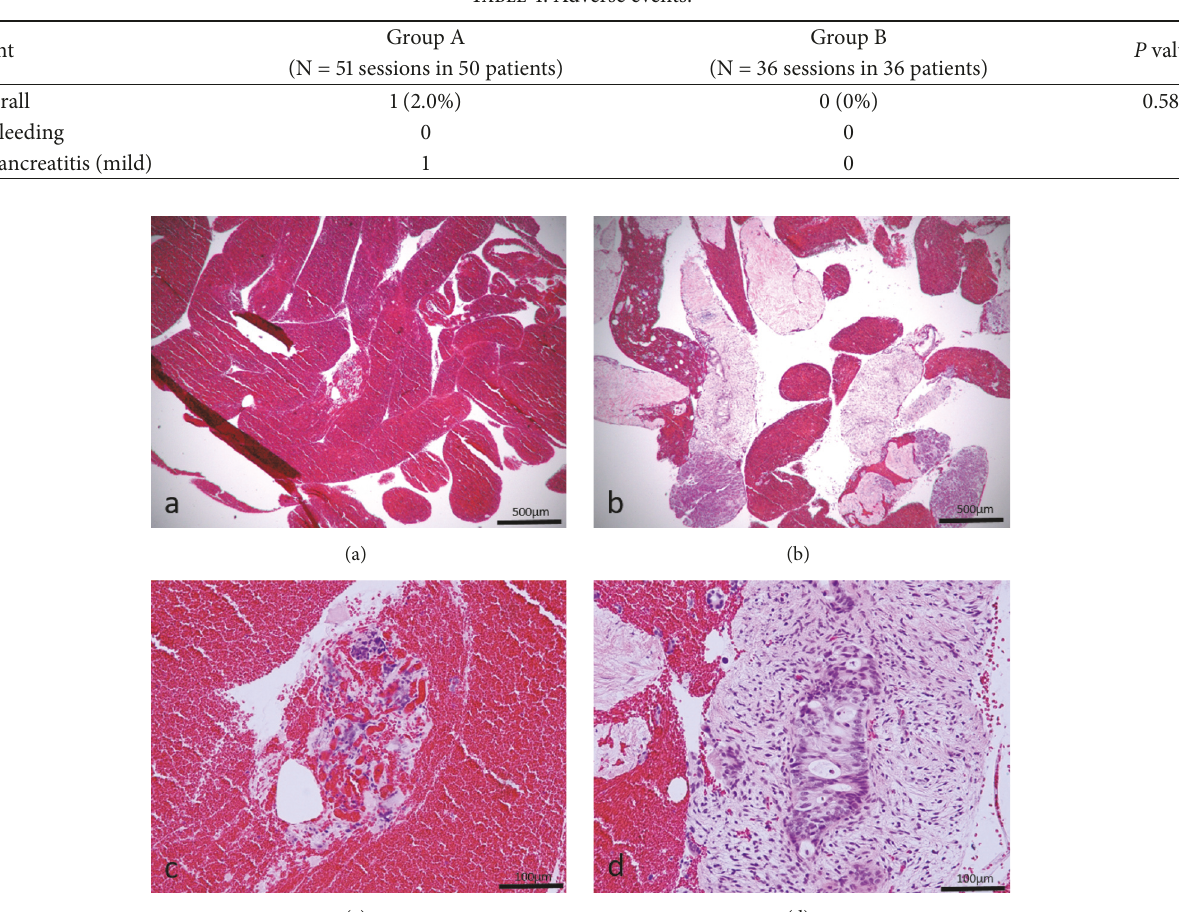
Figure 3: Specimens obtained from the same pancreatic cancer lesion using both a conventional fine needle aspiration (FNA) needle (a, c) and a Franseen needle (b, d). The specimen obtained by the FNA needle shows many blood clots (a), whereas the specimen obtained by the Franseen needle shows good core tissues with low-power field magnification. (c) Scattered atypical cells can be identified in the blood clots with high-power field magnification, but they are insufficient for a cancer diagnosis. (d) A component of atypical cells with enlarged nuclei in the fibrous stroma is detected with high-power field magnification, consistent with ductal carcinoma of the